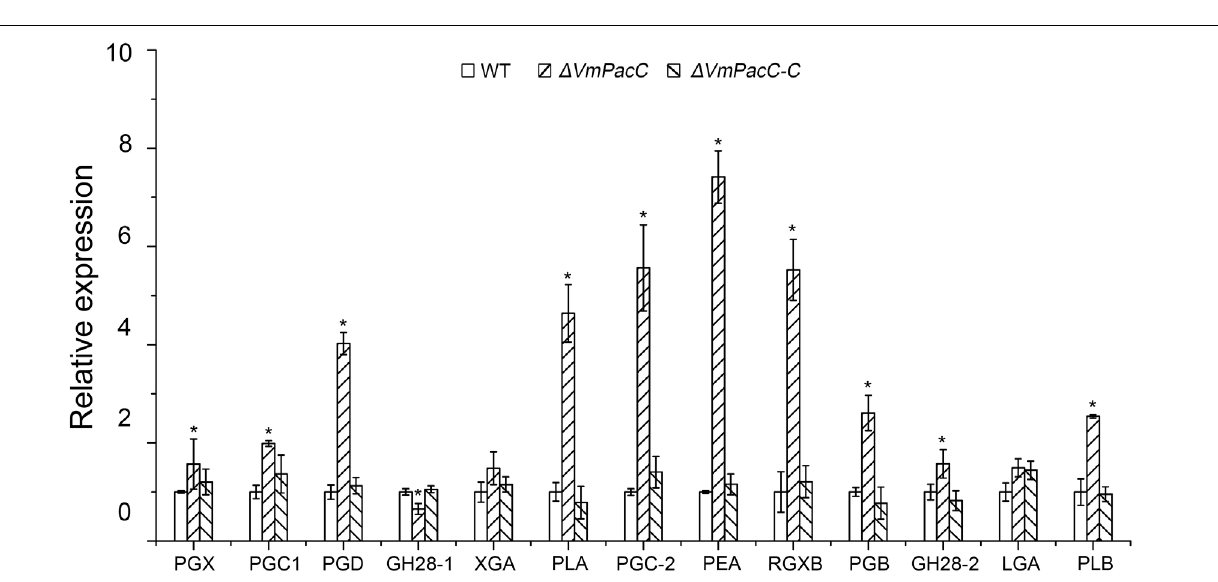
FIGURE 5 | Expression levels of pectinase genes in wild-type, deletion mutant, and complemented mutant strains determined by qRT-PCR. RNA samples were isolated from lesion borders of apple tree bark at 3 days post-inoculation. Wild-type expression levels were arbitrarily set to 1. The mean was calculated using data from three independent biological replicates. The asterisk represents a statistically significant difference compared to